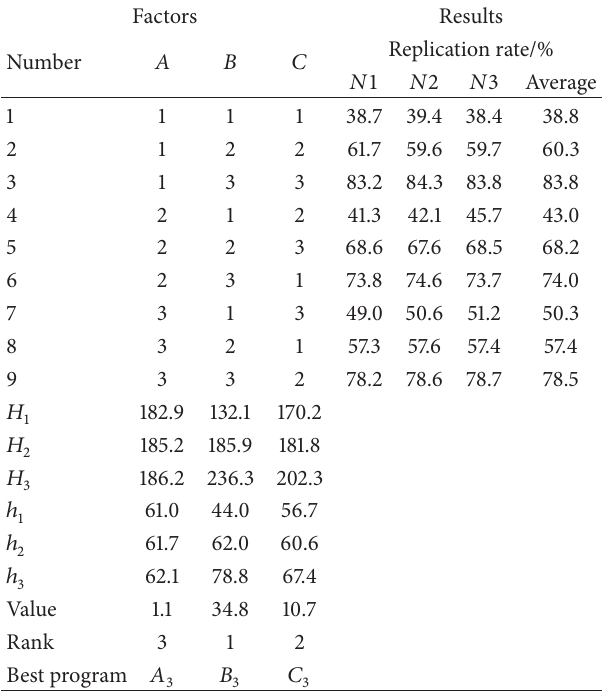
Table 2: The coupling test analysis table of three factors 𝐴 , 𝐵 , and 𝐶 . Factors